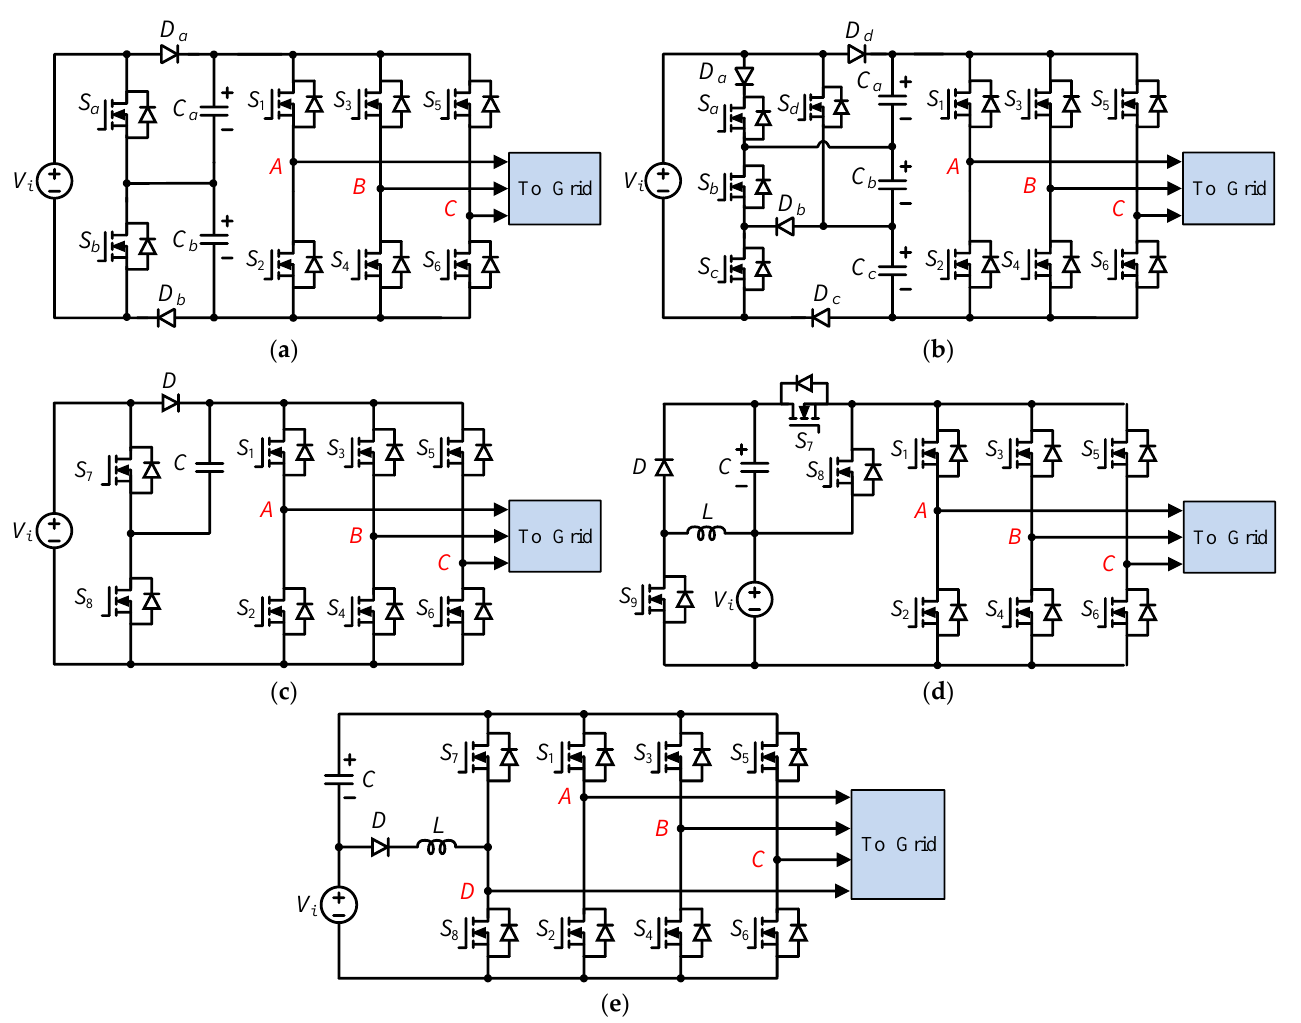
Figure 5. CMV reduction topologies with boosting capability. ( a ) Switched-capacitor voltage-doubler inverter [53], ( b ) triple-voltage boost inverter [54], ( c , d ) switched-capacitor-based inverters [55,56], ( e ) boost inverter with four-leg [57].